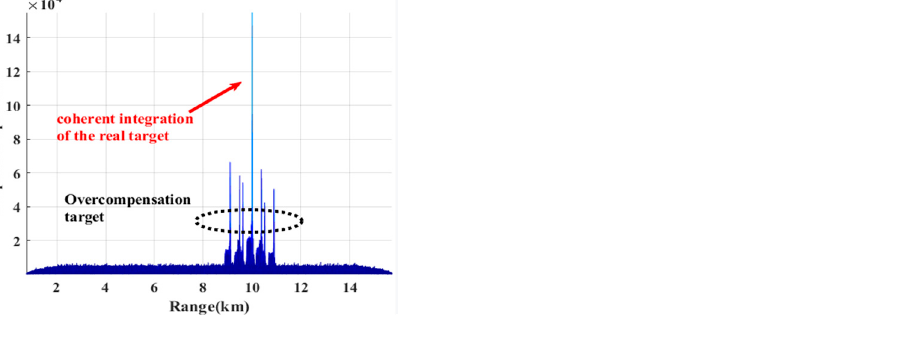
Table 3. Improved algorithm processing